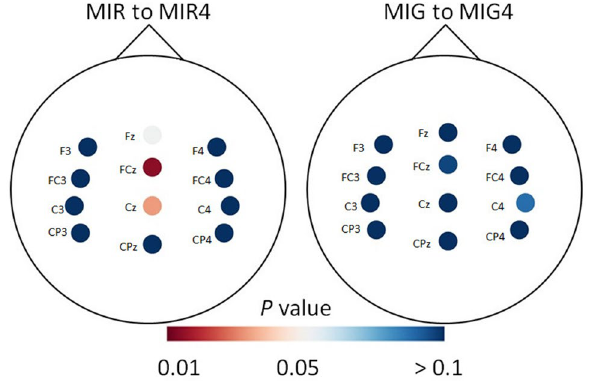
Figure 6. Heatmap depicting the P values of pairwise comparison for ERP amplitude between measurement sessions (before and after training) for motor imagery of reaching (MIR to MIR4) and motor imagery of grasping (MIG to